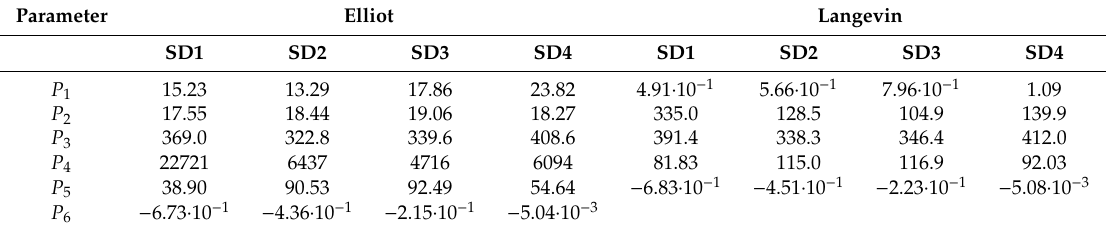
Table 11. Calculated parameters of the 9S20 decreasing first-order reversal curves.